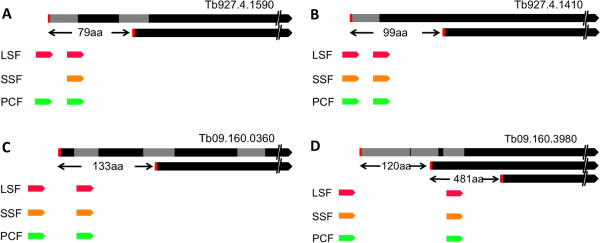
Alternatively spliced transcripts and their corresponding protein products. (A) Tb927.4.1590, Hypothetical protein. (B) Tb927.4.1410, Hypothetical protein. (C) Tb09.160.0360, Hypothetical protein. (D) Tb09.160.3980, eukaryotic translation initiation factor 4 gamma. Arrows in red, orange and green indicate splice sites detected in long slender form (LS), short stumpy form (SS) and procyclic form (PC) respectively. Black bars indicate ORFs and grey bars indicate peptide coverage. Potential start codons are shown in red.